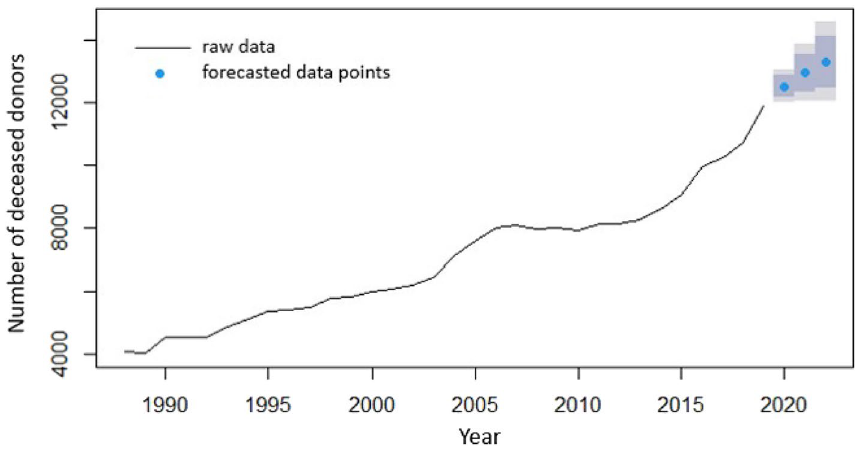
Figure 9. Raw data for deceased organ donors and forecasted data (blue dots) depicting predictions by the ARIMA model for years 2020 through 2022. Also shown are the 80% confidence interval (dark grey) and the 95% confidence interval (light